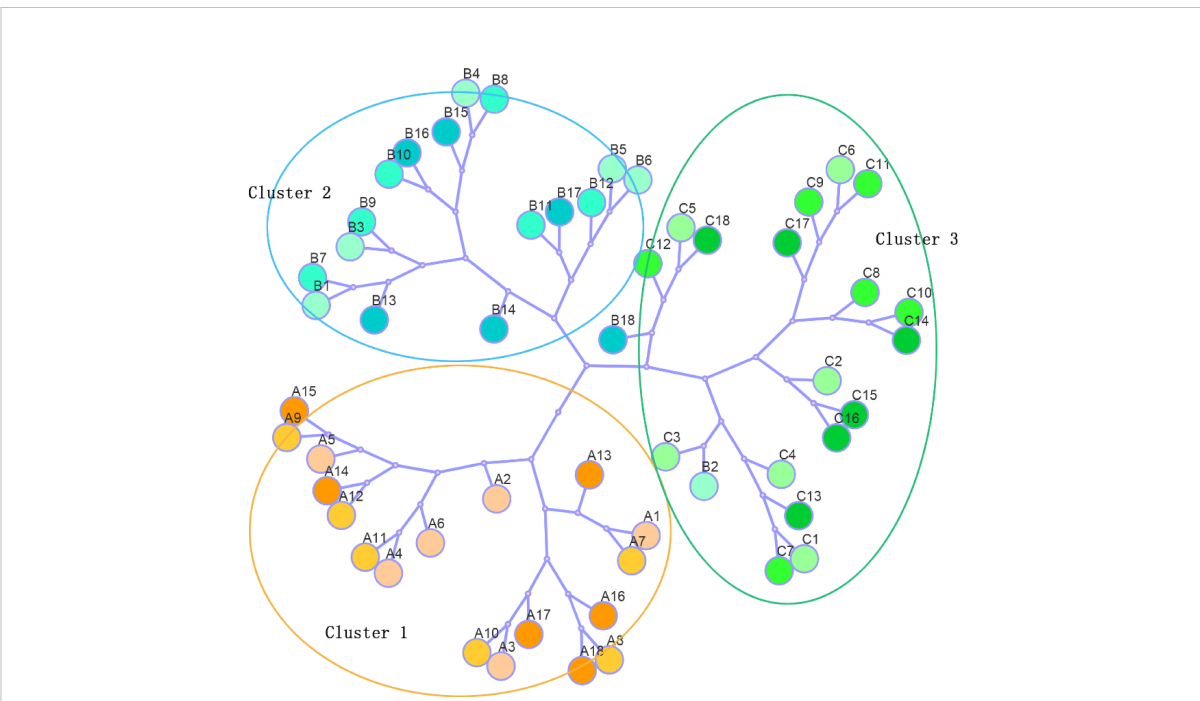
FIGURE 8 Dendrogram was exhibited by cluster analysis of A. marina , A. corniculatum and K. obovata under different upwelling treatment based on the Euclidean distance using physiological and biochemical traits. A represented A. marina (yellow circles), B represented A. corniculatum (blue circles), C represented K. obovata (green circles). Numbers 1-18 represented 5°C upwelling stress-0h, 6h, 12h, 24h,72h and 168h; 10°Cupwelling stress-0h, 6h, 12h, 24h, 72h and 168h; 15°C upwelling stress-0h, 6h, 12h, 24h, 72h and 168h.